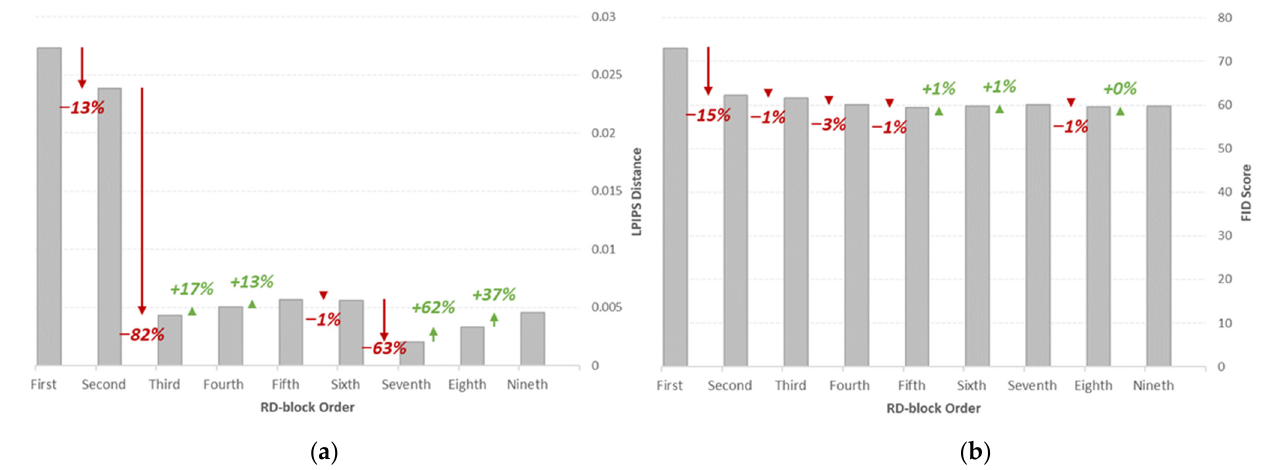
Figure 10. ( a ) LPIPS and ( b ) FID metrics of the synthetic images generated at different orders (single RD activation). Performance metrics are also summarized in Table S1.